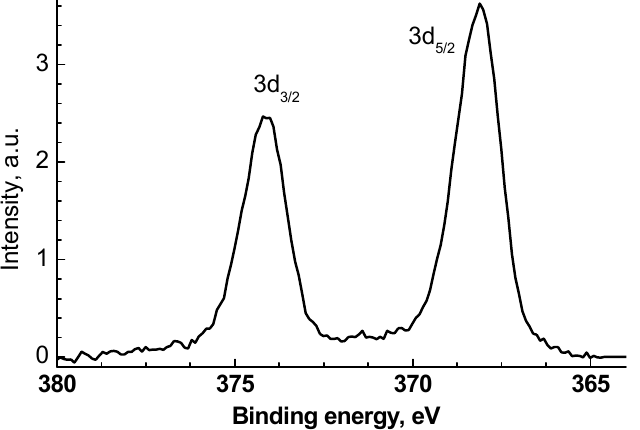
Figure 8. The Ag 3d high-resolution spectrum of the VM/Ag 0 /ZnO sample .